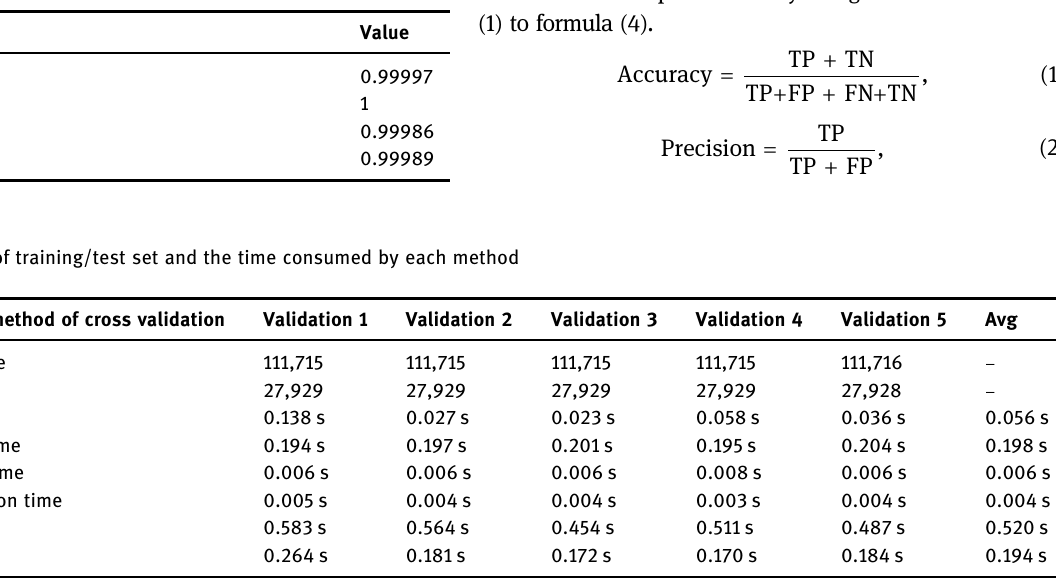
Table 3: Evaluation parameters of outlier detection model